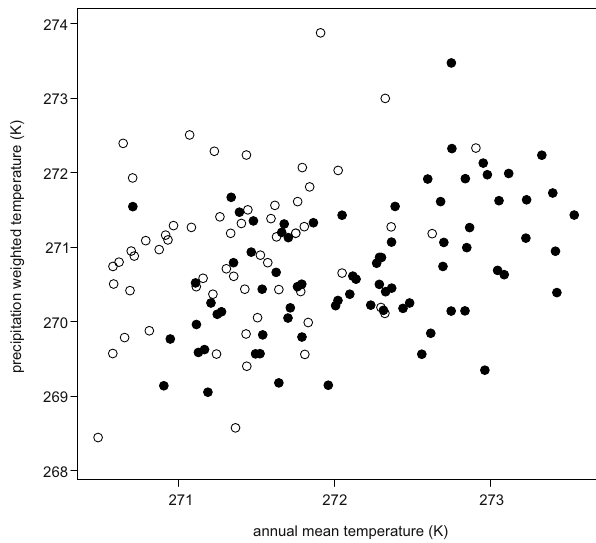
Fig. 7. Comparison of annual mean temperature versus PWT based on daily data from the Great St Bernard in the periods 1864–1924 (open circles) and 1934–2010 (filled circles).